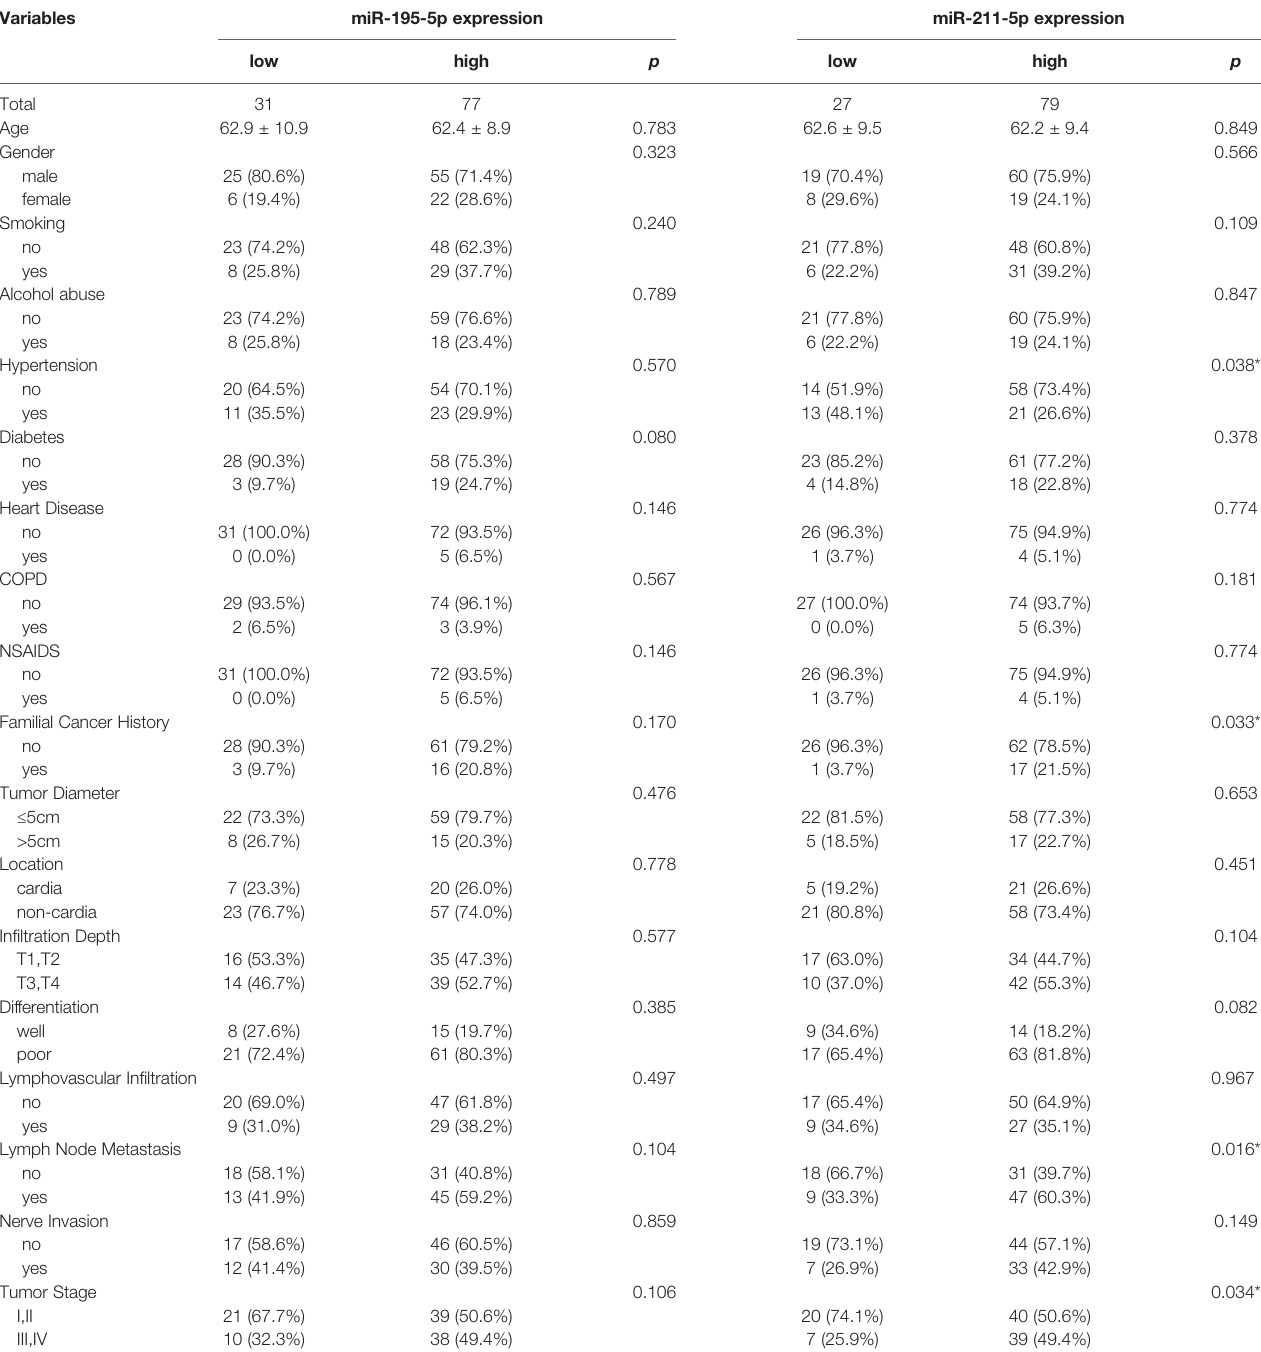
TABLE 1 | Relationship between miR-195-5p and miR-211-5p expression and various clinicopathological variables. Variables miR-195-5p expression miR-211-5p expression low high p low high p